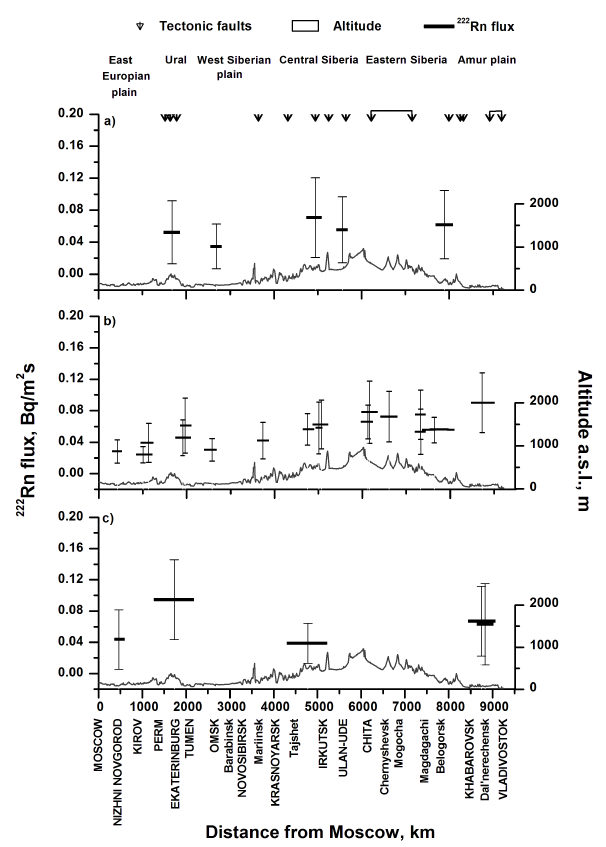
Fig. 6. 222 Rn soil fluxes over Russia calculated from the spring (a) , summer (b) and autumn (c) expeditions. The length of each rectan- gle corresponds to the route part (in km) for which 222 Rn flux was estimated. The joined arrows indicate the strong faults crossing the